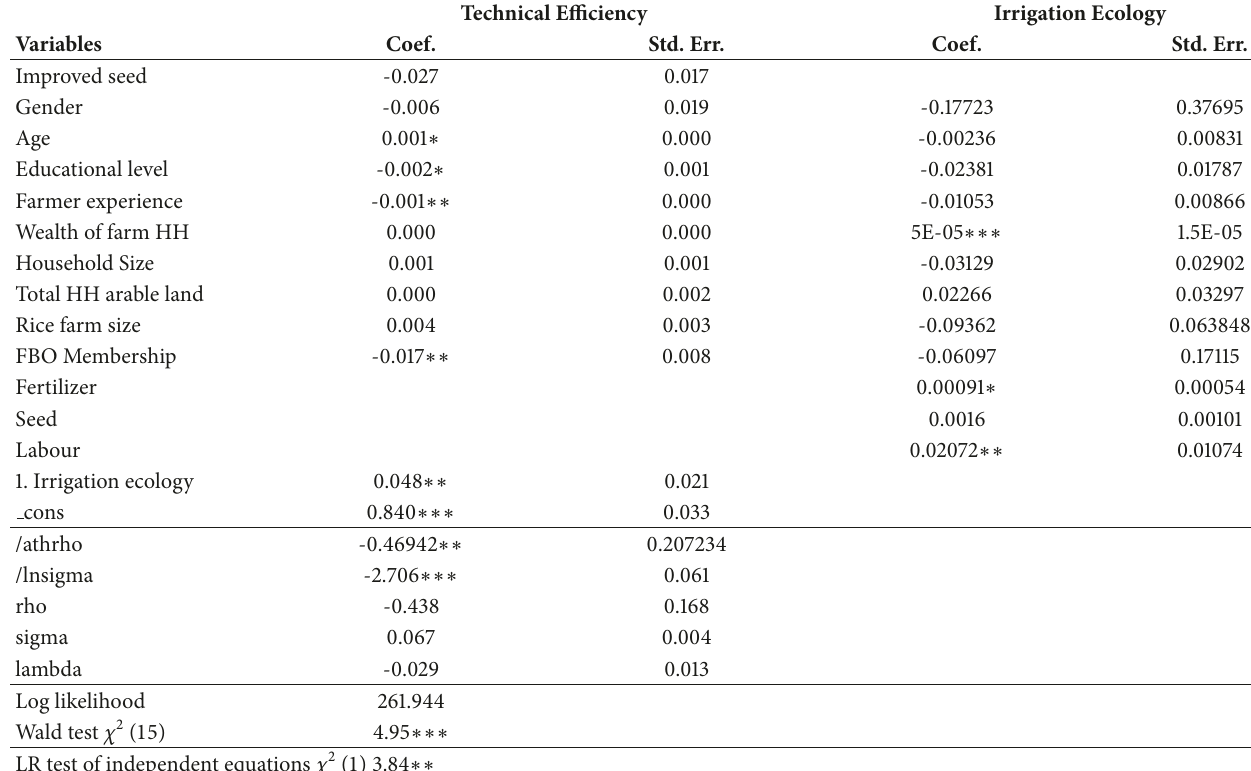
Table 7: Estimates of the endogenous treatment effect model of impact of irrigation ecology on technical